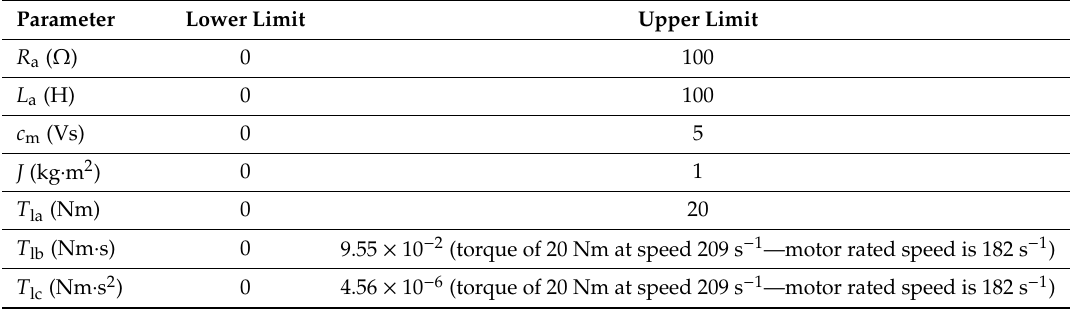
Table 8. Limits of the parameters.